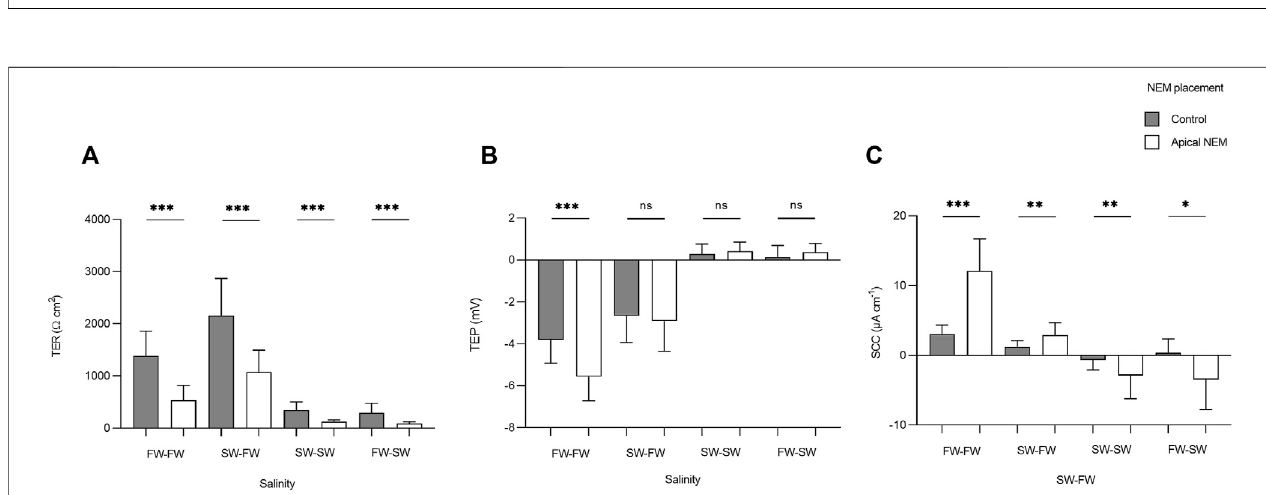
FIGURE 6 | Barcharts showing the effect of salinity on (A) transepithelial resistance (TER), (B) transepithelial potential (TEP), and (C) short-circuit current (SCC). Bars represent means and whiskers represent SD. Groups not sharing a letter differ signi fi cantly based on the results of Welch ’ s ANOVAs and post-hoc Games- Howell tests.